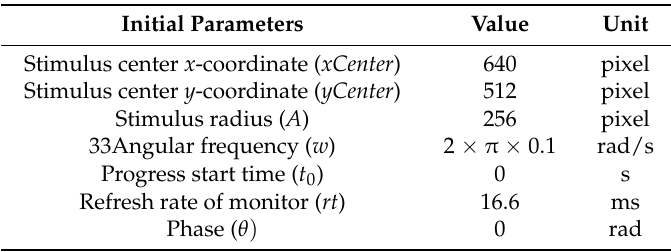
Table 1. Moving target initial values.